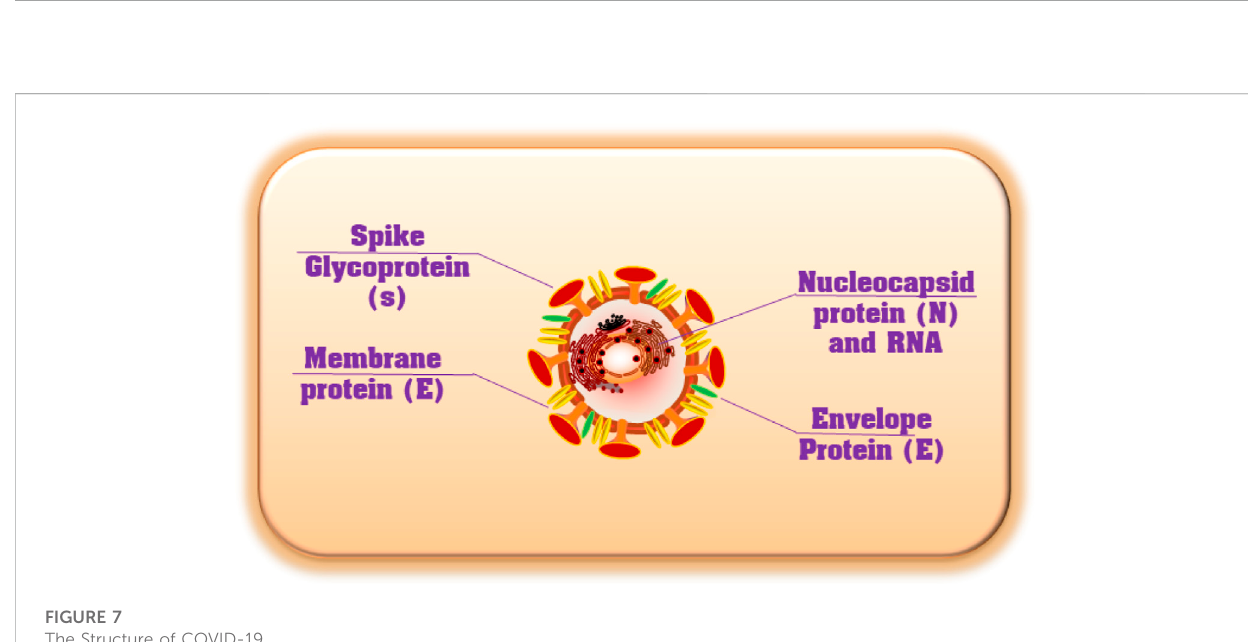
FIGURE 7 The Structure of